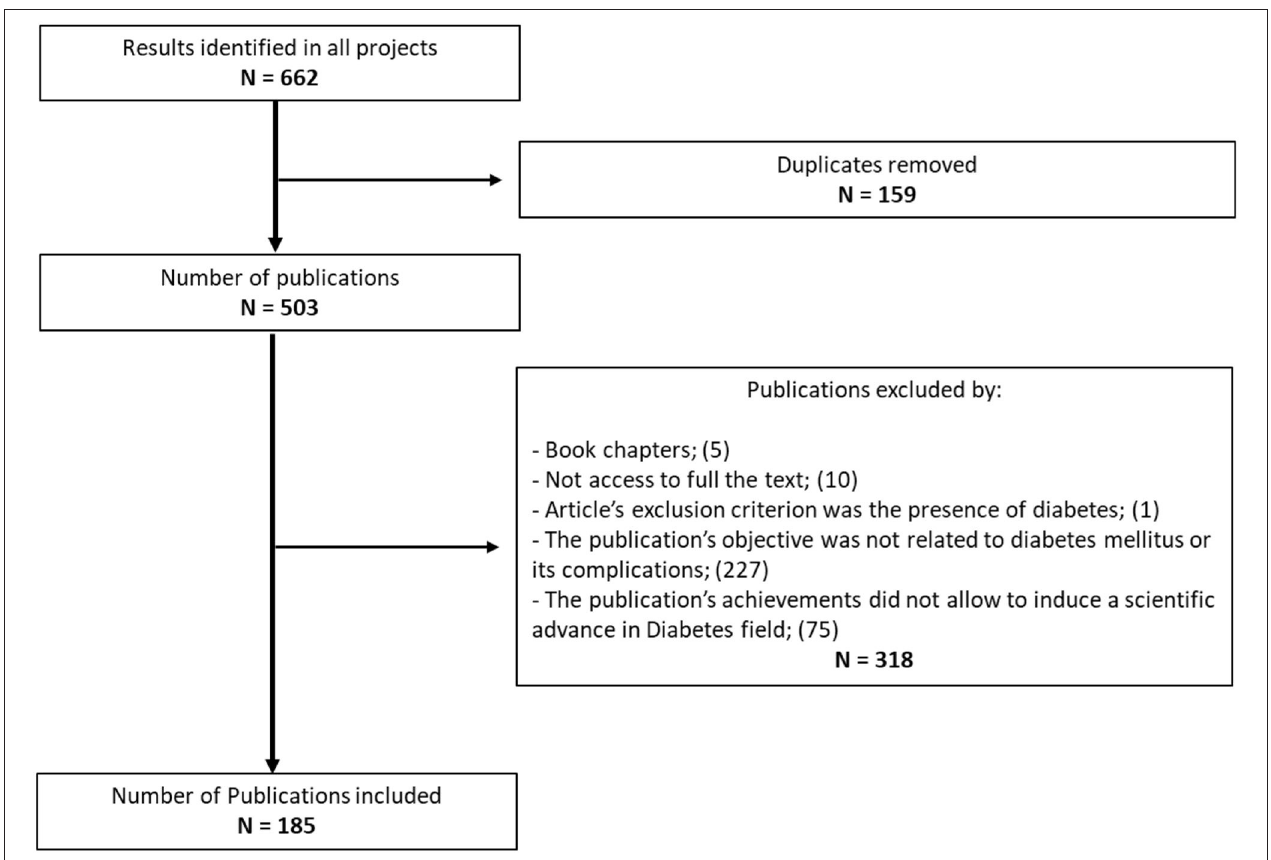
FIGURE 1 | Flowchart of literature